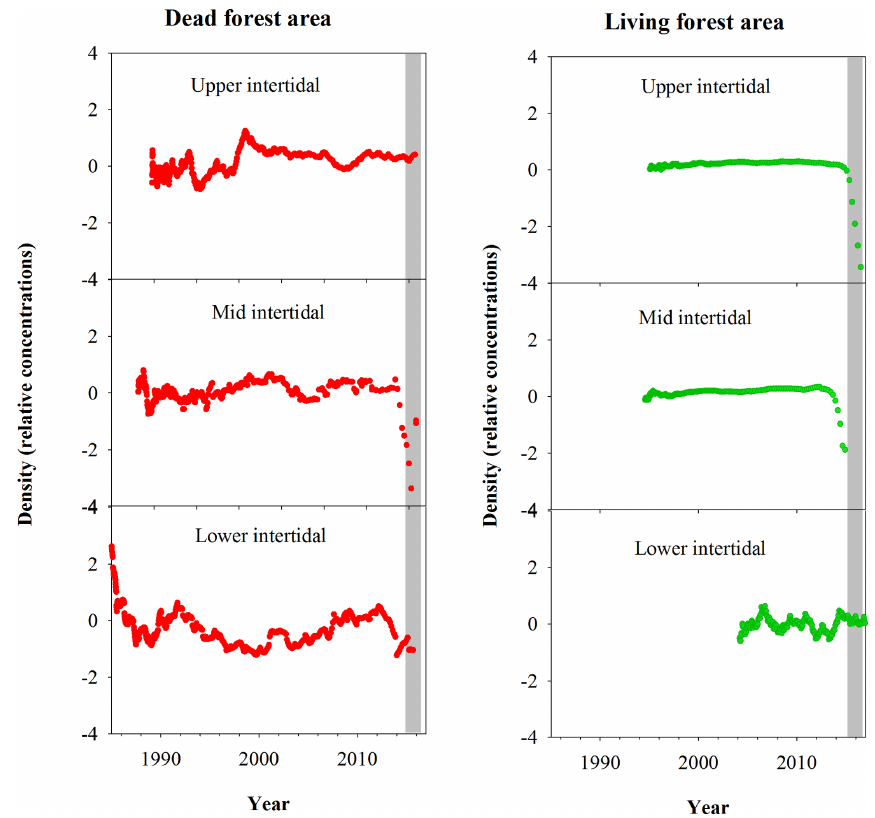
Figure 8. Normalized wood density (relative concentrations) in mangrove wood over time in living (green dots) and dead (red dots) mangrove areas of the Gulf of Carpentaria, Australia. The grey bar represents the time period of the dieback